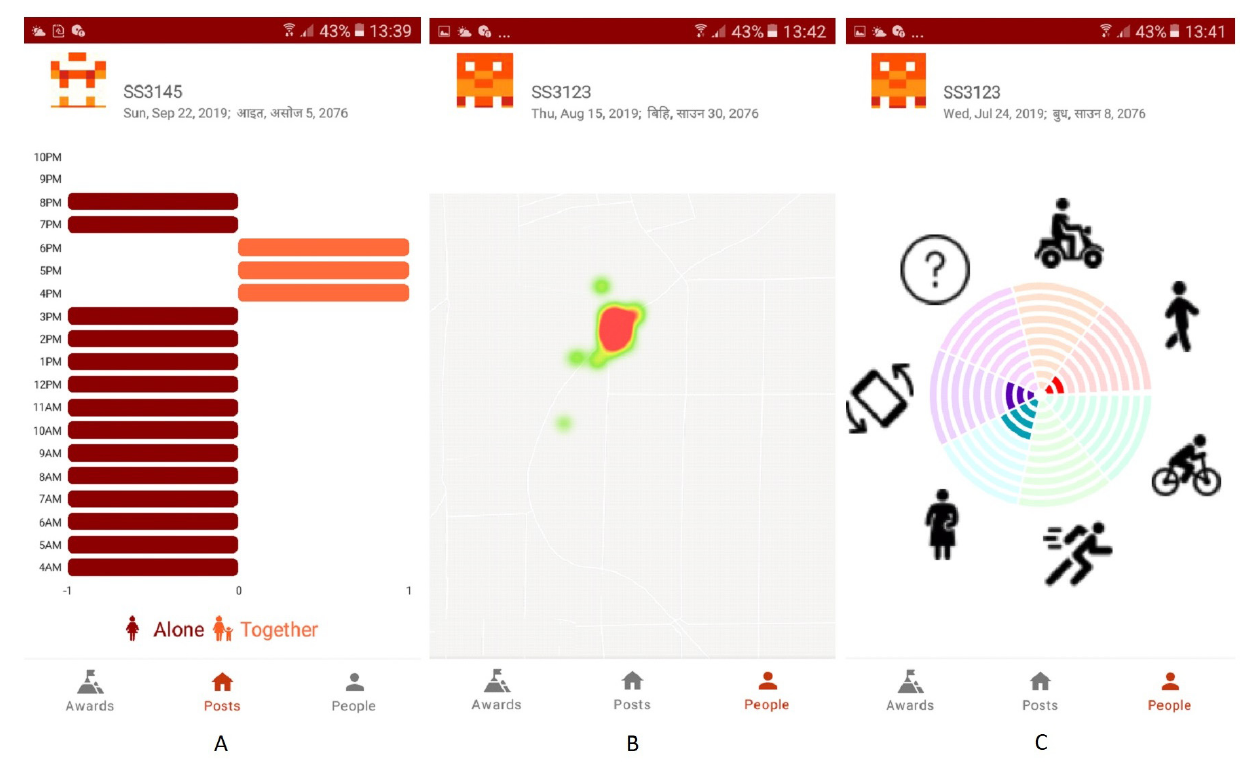
Figure 2. Proximity data ( A ), Global Positioning System heat map ( B ), and activity data ( C ) as visualized in StandStrong